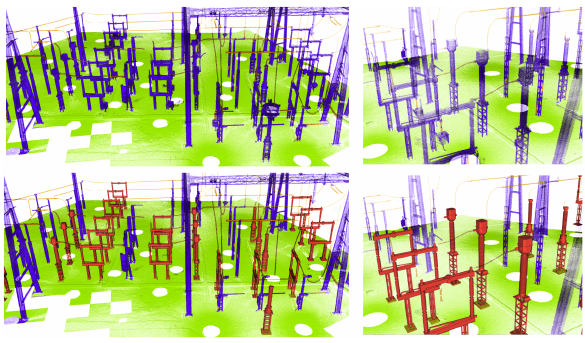
Figure 12. On top, the 3D scene where the ground (green), the wires (yellow) and other objects (purple) were segmented. On bottom, objects having their CAD counterpart in the catalogue were replaced by our modeling